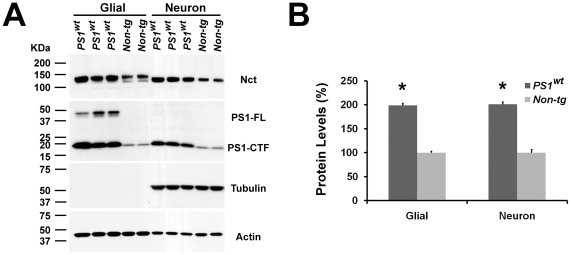
Increase of γ-secretase in primary neurons and non-neuronal cells derived from PS1 mice.(A) Protein extracts (20 µg each) from primary neuronal and non-neuronal cultures derived from brains of PS1 and non-transgenic control mice were immunoblotted with anti-sera specific to Nct, PS1-CTF, β-Tubulin III or Actin. (B) Quantification of Nct signals in protein blot of primary neuronal and non-neuronal cell extracts by Image J program. The signal density was normalized using Actin signals derived from the same blot.